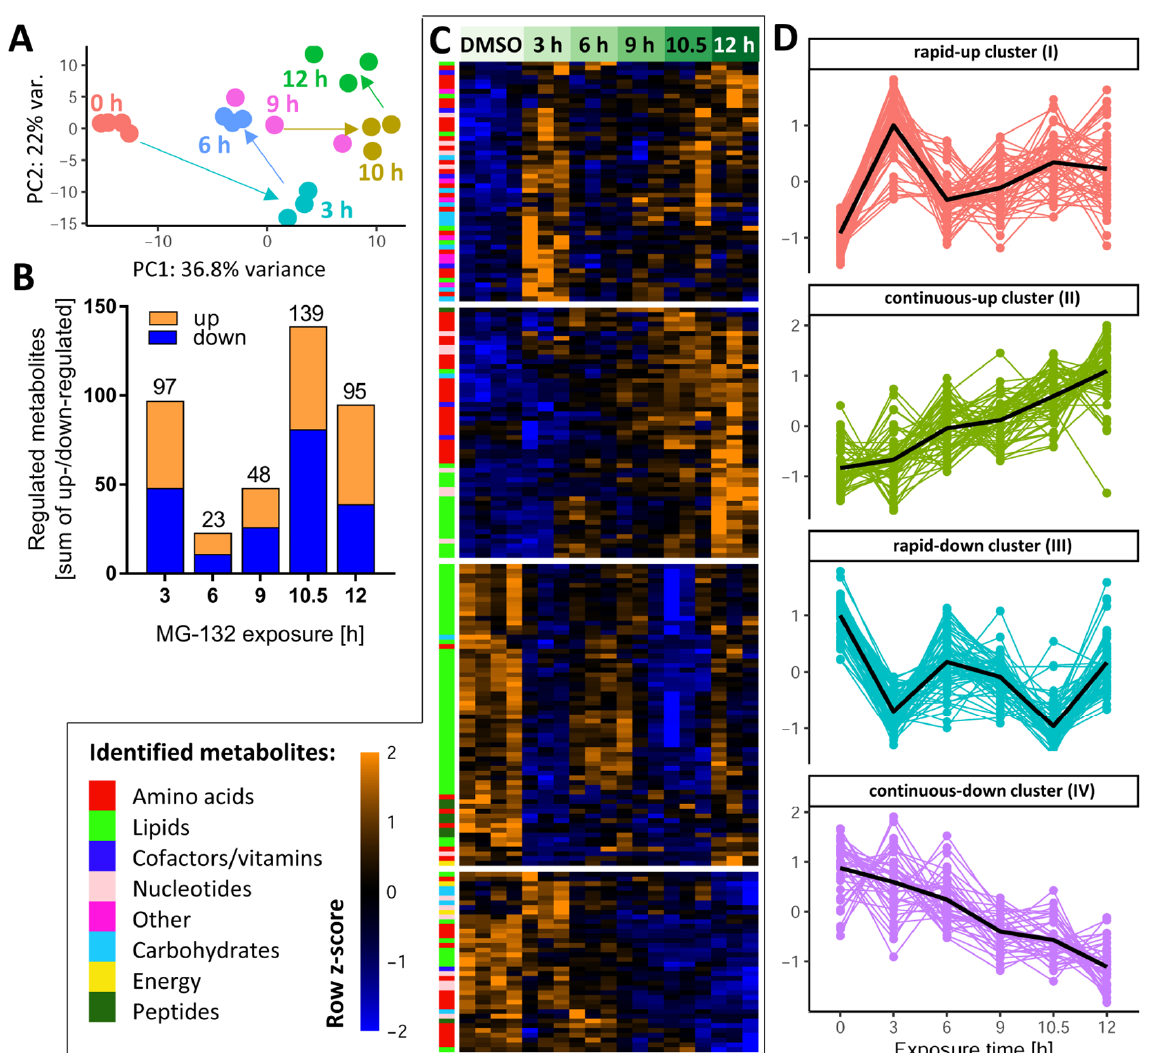
Figure 3. Dynamics of the MG-132-induced metabolic changes over time. Altogether, 386 cellular metabolites were quantifiable under the control condition. Based on LIMMA statistics, 206 of these metabolites were changed significantly at least at one time point by MG-132 treatment. A high-level overview of these metabolome changes is given here. ( A ) Principal component analysis (PCA) of all changed metabolites: the first two dimensions are plotted, with each analyzed sample displayed as filled circle (color-coded according to the sampling time). The axes were scaled according to the variance covered by the principal components (PCs). ( B ) The absolute numbers of metabolite changes for each exposure time are displayed on top of the bars. The colored segments indicate the numbers for the two directions of regulation: up (orange) and down (blue). ( C ) Unsupervised clustering of metabolite time-profiles. The heat map colors represent the z-scores of the row-wise normalized relative levels for each metabolite. All replicates and conditions are shown. A color code was used to visualize the major biochemical groupings (e.g., lipids, nucleotides) of the metabolites. The clustering dendrogram is not shown, but the four major clusters are indicated by white separating lines. ( D ) For each of the clusters, the time profiles of their associated metabolites are given. Clusters are named by the average time profile of their constituents (e.g., rapid-up or continuous-down). The metabolite z-score values were averaged per treatment condition in each cluster and are shown as black lines. Metabolites were considered to be regulated if the false discovery rate–corrected p -value for at least one time point was ≤ 0.05. DMSO, dimethyl